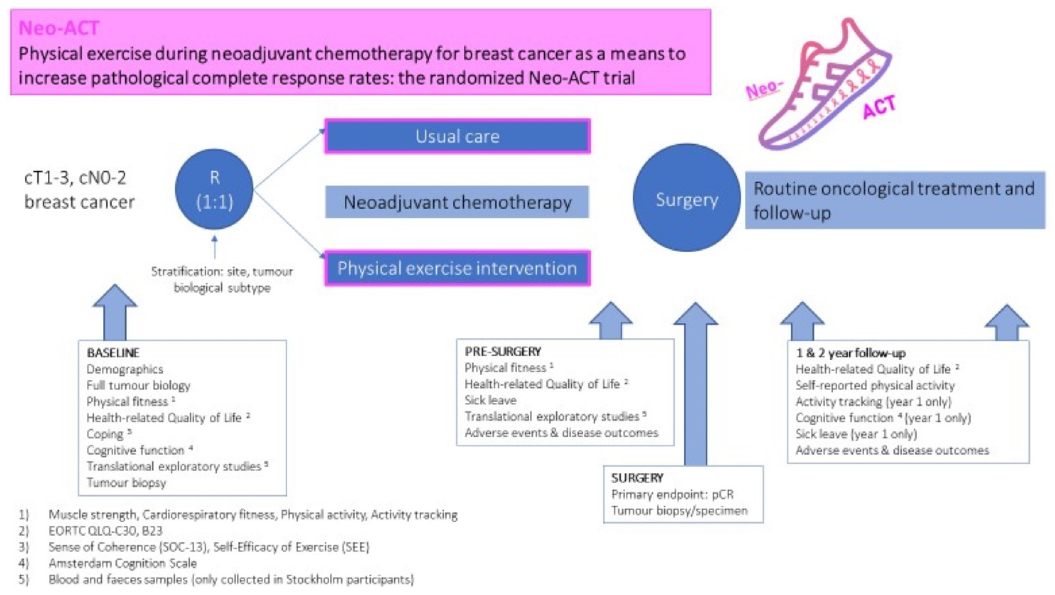
Fig 2. Schematic overview of the Neo-ACT trial.